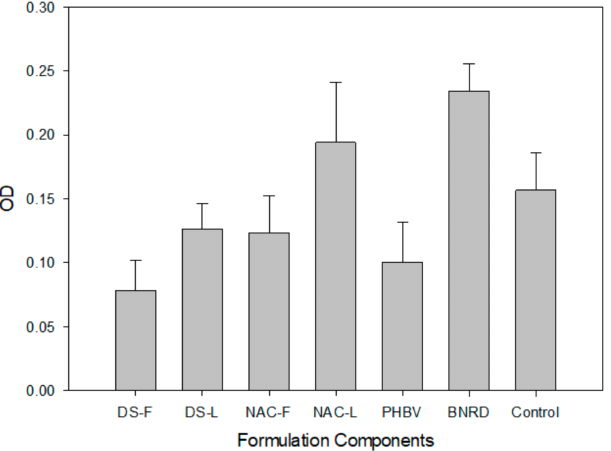
Figure 3. MTT PC12 viability studies in response to the drug-free (DS-F) and drug-loaded (DS-L) hydrogel conduits; the NAC-free (NAC-F) and NAC-loaded (NAC-L) electrospun intraluminal fibers; pure electrospun PHBV fibers; and the final assembled biosimulated nerve repair device (BNRD) ( n = 3).